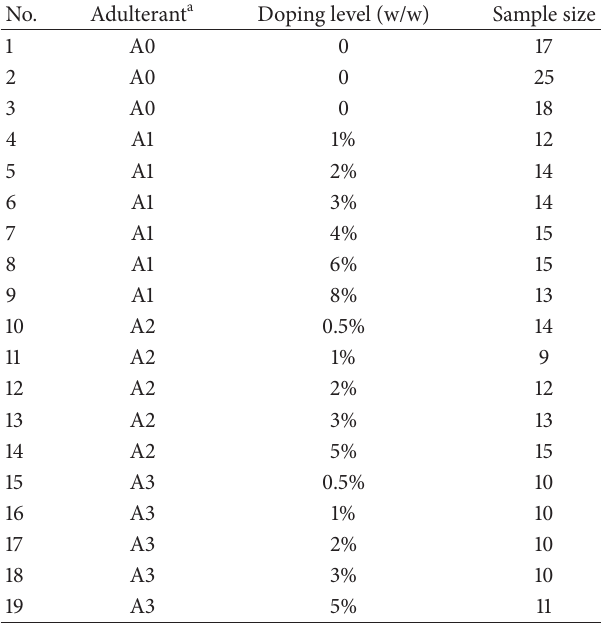
Table 1: Pure and adulterated yogurt samples